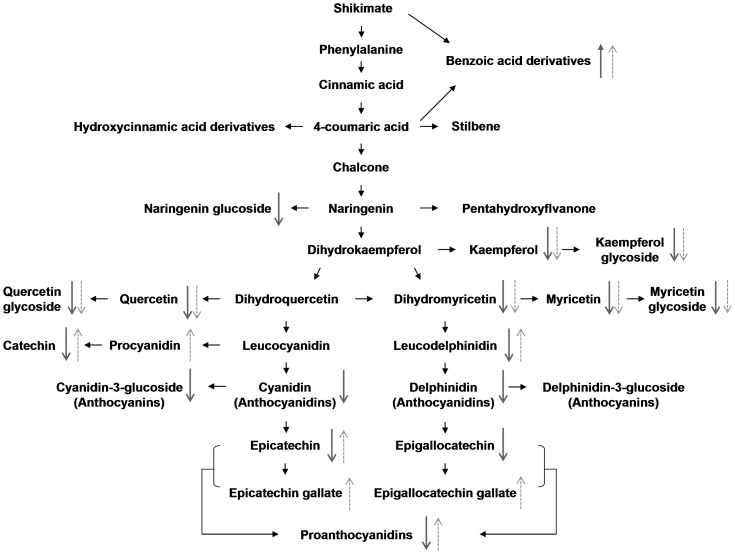
Schematic presentation of the phenylpropanoid/flavonoid pathway as affected by light intensity and temperature based on metabolomics analysis by UPLC-Q-TOF MS.Solid and dotted arrows represent the quantitative changes of metabolites with the changes of light and temperature, respectively. The up and down arrows indicate increasing and decreasing effects, respectively, of reduced light intensity by shading compared to un-shaded CK or by reduced temperature in Nano compared to Black Net.